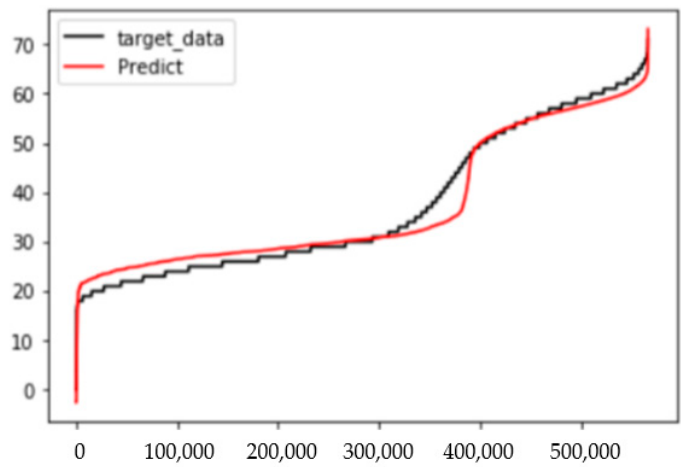
Figure 6. Test model fit using the test set.